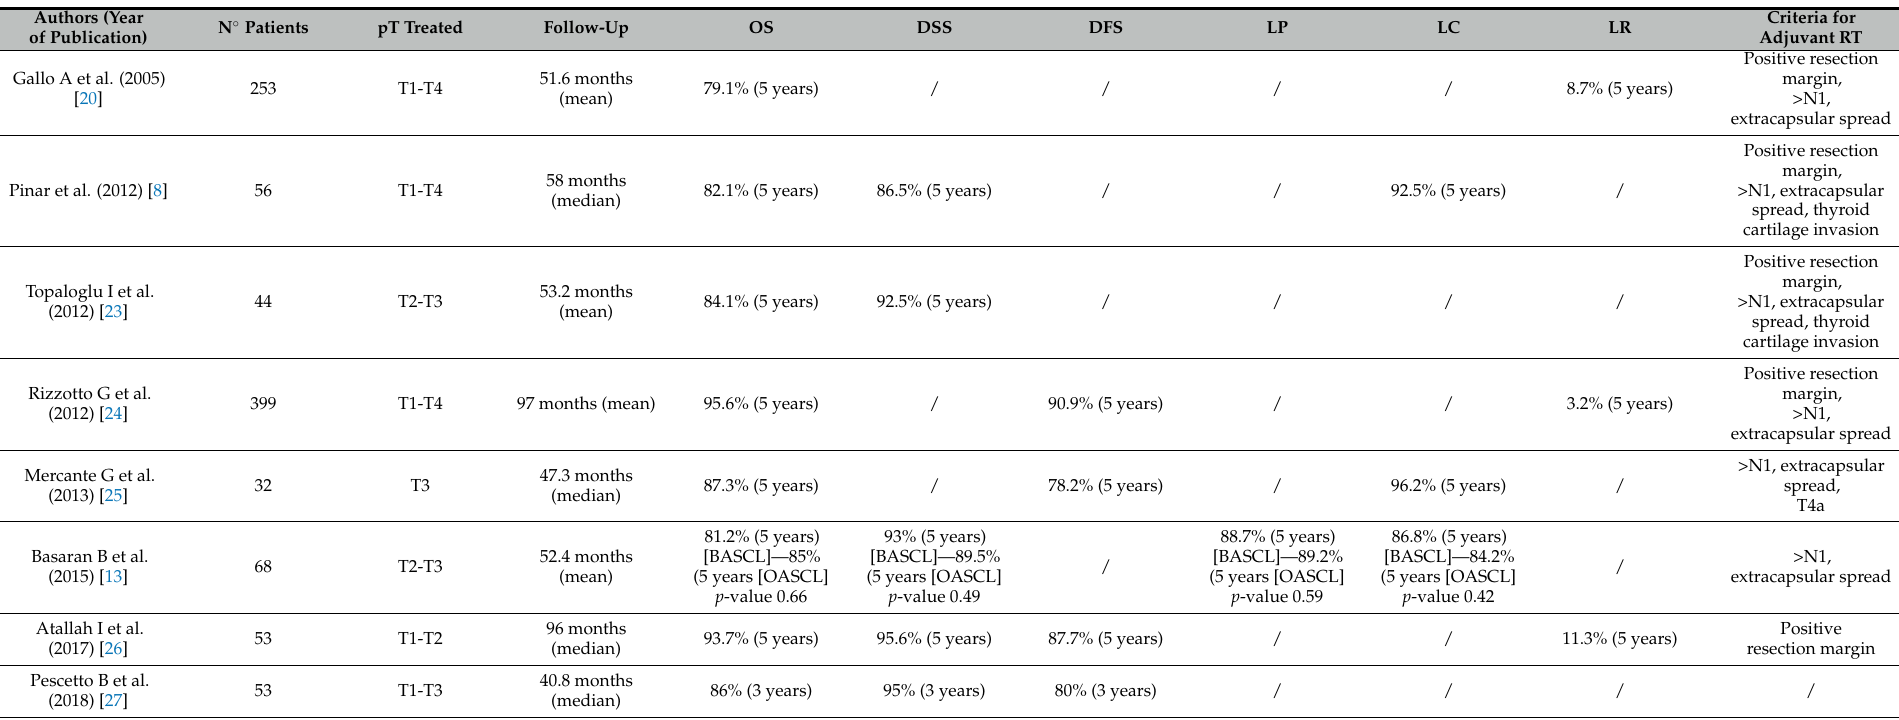
Table 3. Adjuvant radiotherapy after primary OPHL type II: characteristics of included